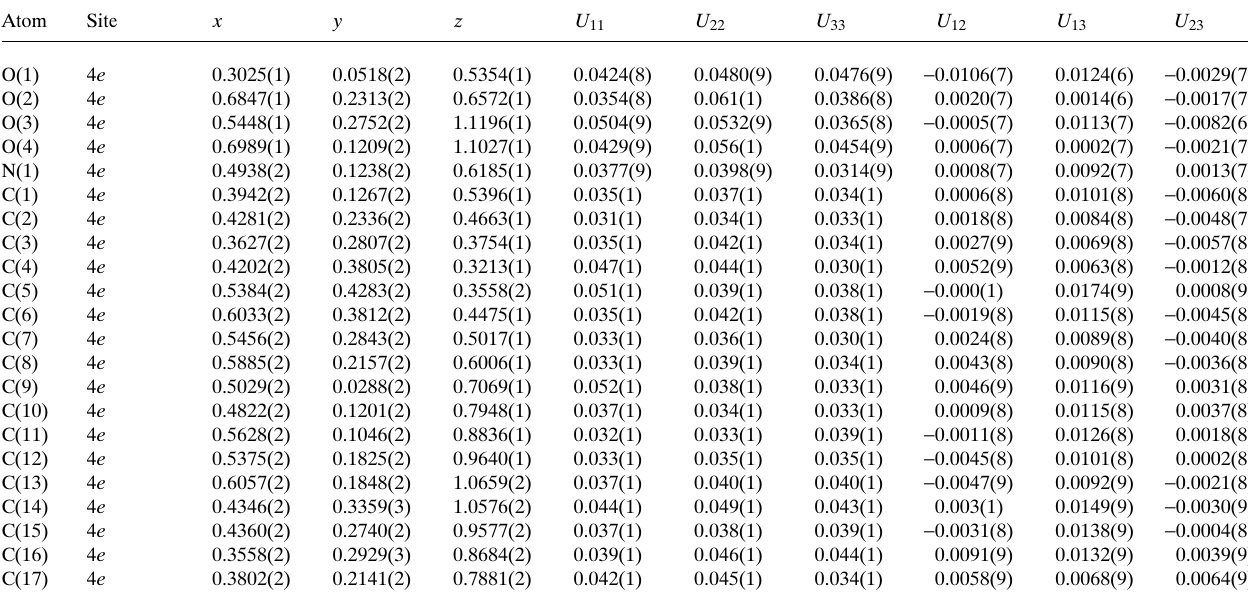
Table 3. Atomic coordinates and displacement parameters (in Å 2 )